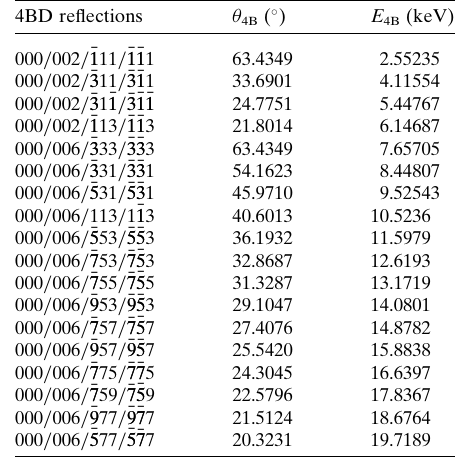
Table 1 Typical 4BD reflections from the silicon (001) surface for E < 20 keV. 4BD